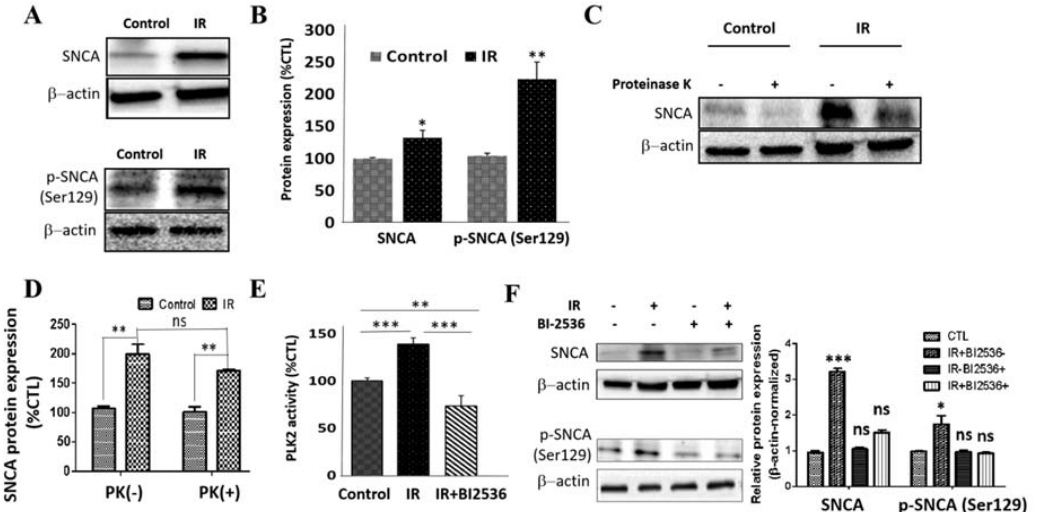
Figure 5. IR elicits increased total, Ser129 ‐ phosphorylated, and proteinase K ‐ resistant SNCA through a polo ‐ like kinase 2 ‐ dependent mechanism. ( A ) Representative Western blot images and ( B ) densitometry ‐ based graph showing the effect of IR on the expression of total (upper) and Ser129 ‐ phosphorylated (lower) SNCA proteins in SH ‐ SY5Y cells (SNCA, control: 100 ± 1.8%, IR: 132.1 ± 11.3%, p < 0.05, n = 6; p ‐ SNCA (Ser129): control: 100 ± 3.8%, IR: 214.3 ± 26%, p < 0.01, n = 6). ( C ) Representative Western blot images and ( D ) densitometry ‐ based histograms showing the effect of proteinase K on the expression of SNCA protein in IR and non ‐ IR control SH ‐ SY5Y cells. ( E ) Graphical representation of the effect of 0.0625 nM BI ‐ 2536 on polo ‐ like kinase ‐ 2 (PLK2) activity in IR SH ‐ SY5Y cells, compared to non ‐ IR control cells (control: 100 ± 3.3%, IR: 138.9 ± 6.4%, IR + BI2536: 73.4 ± 10.9%, n = 6). ( F ) Representative Western blot images and histograms showing the effect of BI ‐ 2536 on the expression of SNCA (upper) and p ‐ SNCA (Ser129) (lower) proteins in SH ‐ SY5Y cells. β‐ actin was used as a loading control; ns, p > 0.05, *, p < 0.05, **, p < 0.01, ***, p < 0.001; BI ‐ 2536, selective PLK2 inhibitor.